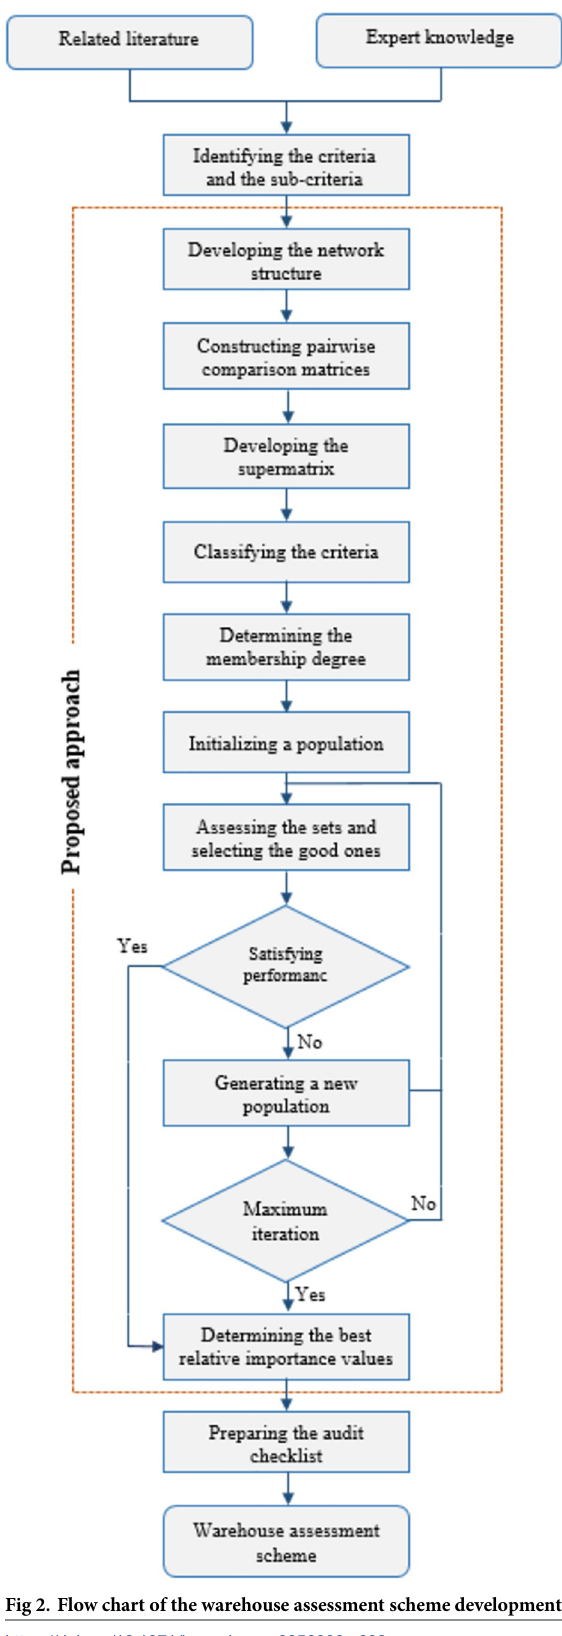
Fig 2. Flow chart of the warehouse assessment scheme